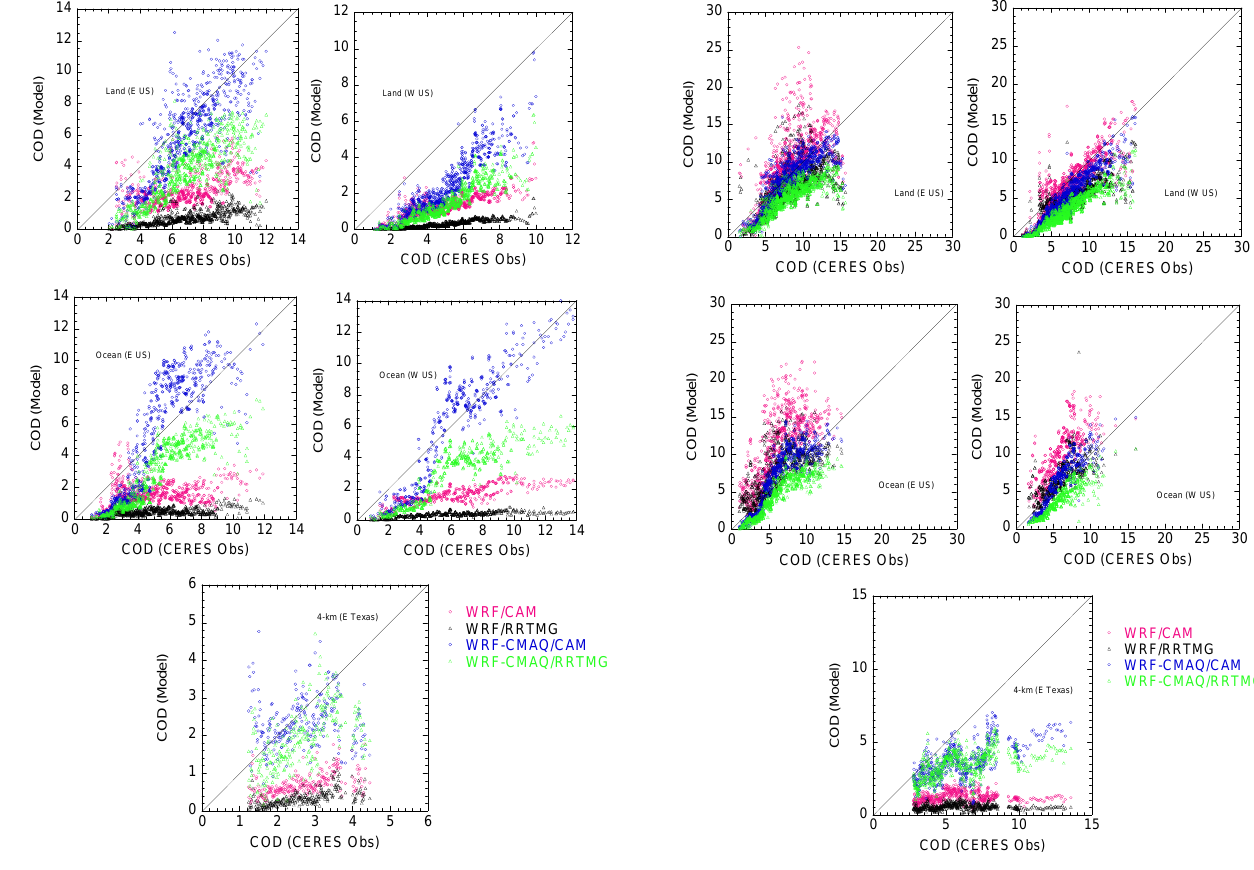
than ∼ 2.5, indicating that both configurations overestimated low clouds, stratocumulus and cumulus. On the other hand, over both the land and ocean areas of the WUS in August 2006, both WRF–CMAQ/CAM and WRF–CMAQ/RRTMG performed very well when ∼ 0.2 < N < ∼ 2.5, and signifi- cantly overestimated the observed N values when N was greater than ∼ 2.5 or when N was less than ∼ 0.2, as shown in Fig. 17, suggesting that both configurations underesti- mated high clouds, cirrus and cirrostratus but overestimated low clouds, stratocumulus and cumulus over the land and ocean areas of the WUS. Figure 17 also shows that there are not many high clouds, cirrus and cirrostratus over both the land and ocean areas of the EUS in August 2006, according to both observations and model results. The results also indi- cate that the WRF default cases underestimate the observed N values when N is greater than ∼ 2.0 for the whole domain, indicating that both WRF/CAM and WRF/RRTMG underes- timated low clouds, stratocumulus and cumulus everywhere. Both WRF–CMAQ/CAM and WRF–CMAQ/RRTMG per- formed very well when ∼ 0.2 < N < ∼ 2.5 over the model do- main, much better than the corresponding WRF/CAM